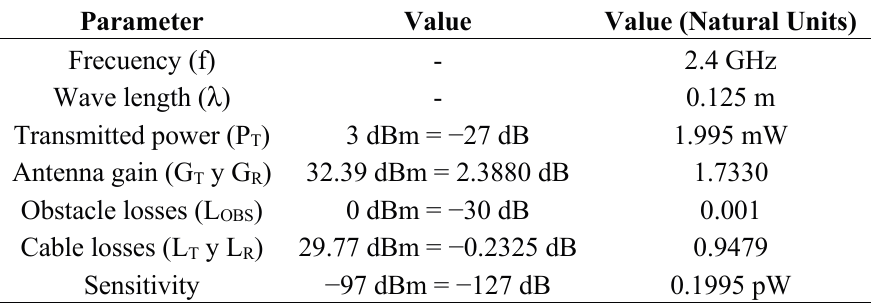
Table 1. Parameters for the coverage